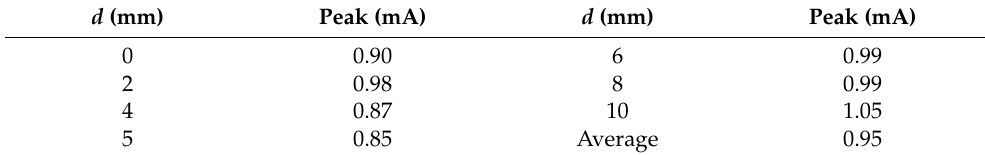
Table 4. The Peak Value of Corona Current for Particle Size = 10 mm.